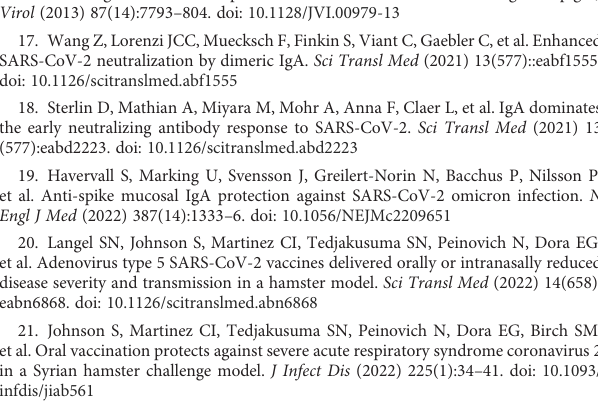
SUPPLEMENTARY FIGURE 1 Raw RLU from spike-speci fi c mucosal IgA. (A) RLU values of RBD or spike speci fi c IgA from oral swabs from placebo (black), rAd5-S-Wuhan (red), or rAd5-S-omicron (blue) vaccinated hamsters. (B) . RLU values of RBD or spike speci fi cIgAfromoralswabsfromplacebo(black),oraladministrationofrAd5- S-Wuhan (red, open circles), intranasal administration of rAd5-S-Wuhan (red, closed circles), or rAd5-S-delta (blue) vaccinated hamsters.n=6, mean and SEM